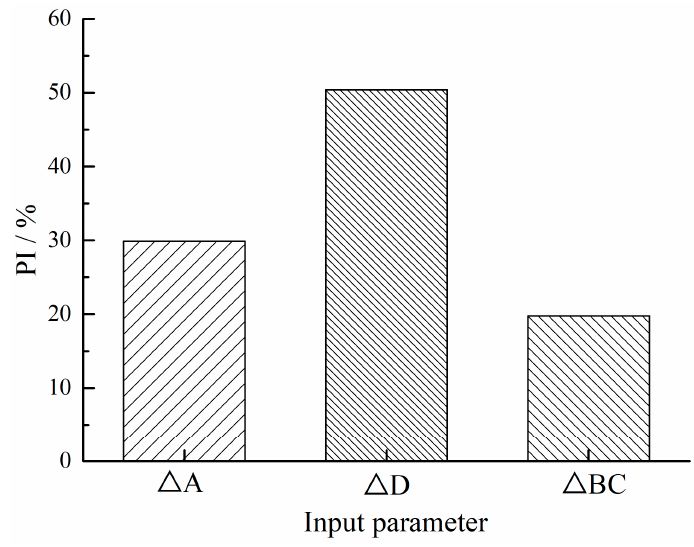
Figure 8. Importance analysis results of input variables.